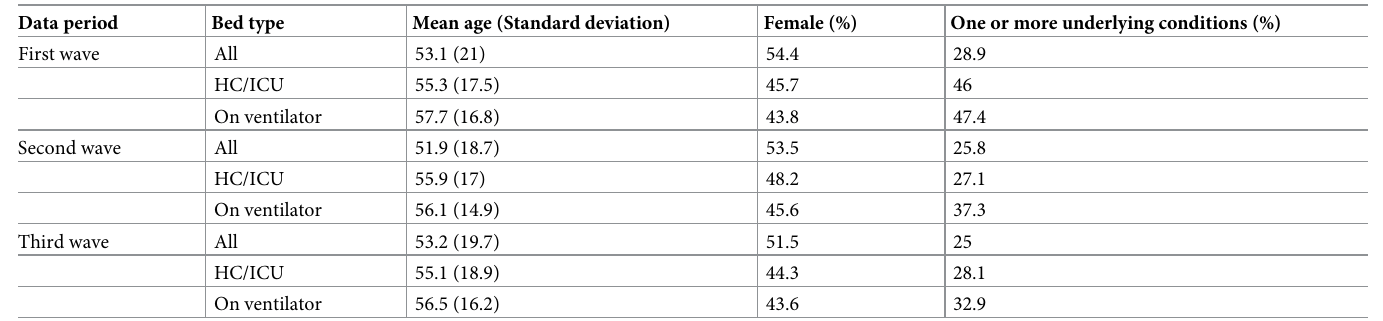
Table 1. Patient characteristics.